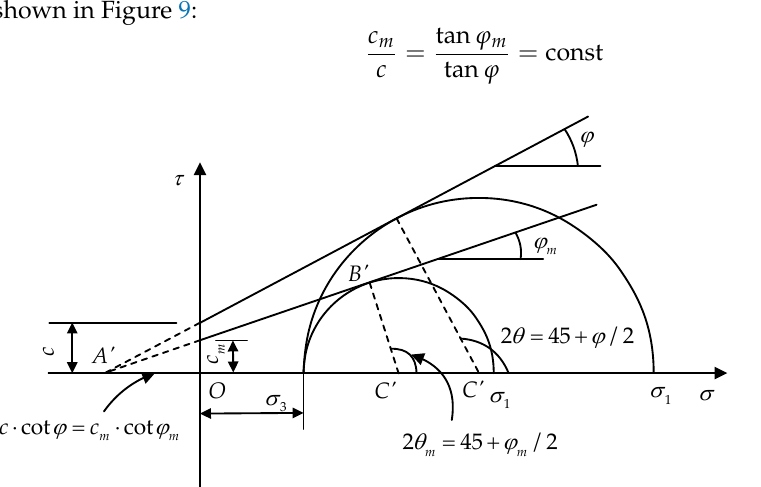
Figure 9. The relationship among the lateral stress change of materials with cohesion–friction, the stress level, and the friction angle.